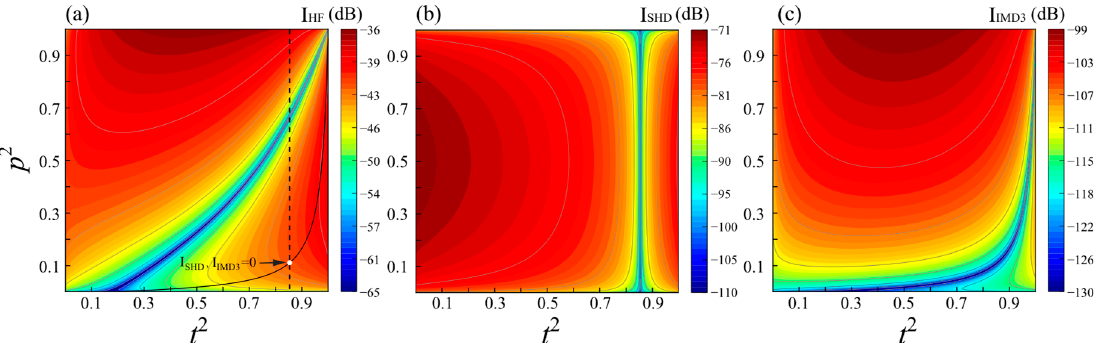
Figure 3. Contour map of the ( a ) I FH , ( b ) I SHD , and ( c ) I IMD 3 as a function of t 2 and p 2 when Δ ϕ = 7/8 π . The dotted and solid black lines in ( a ) mark the zeros points of the I SHD and I IMD 3 , respectively. The white point marks the common zero points of I SHD and I IMD 3 .